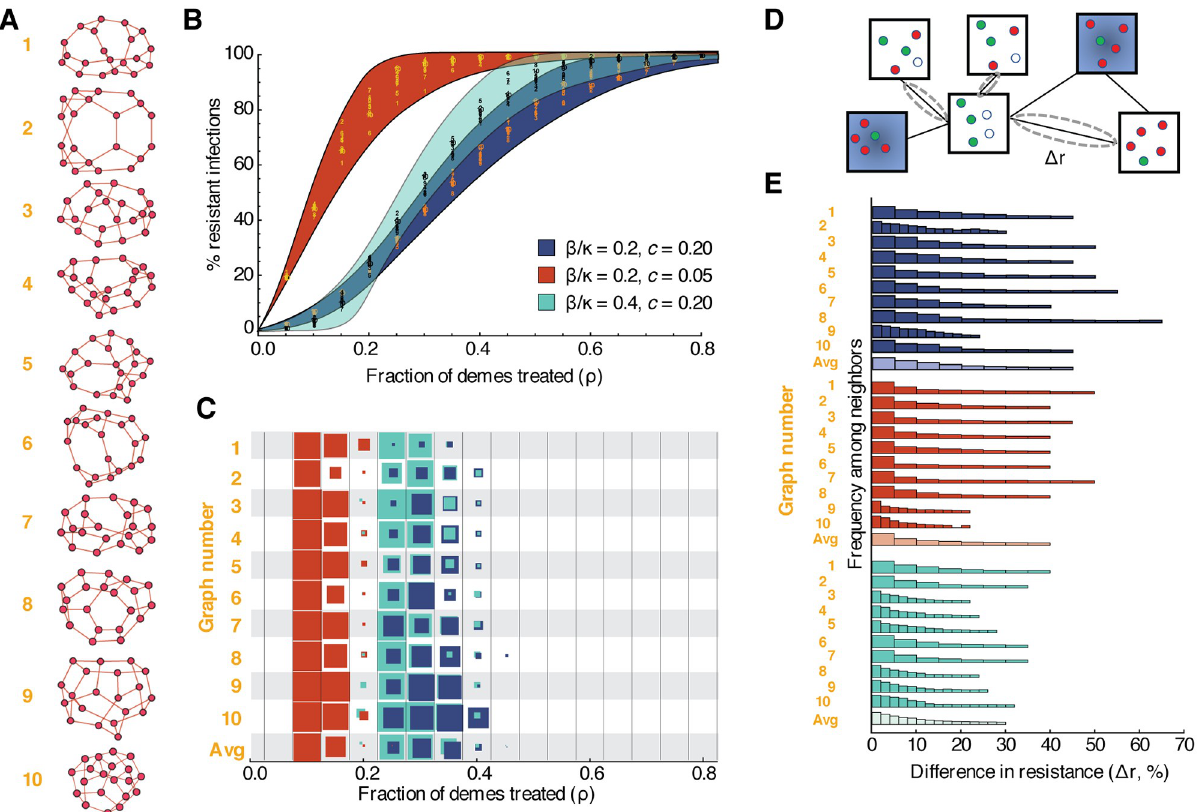
Fig 4. Dynamics of drug-resistant infections in populations consisting of networks of inter-connected demes. A) Randomly generated population structures on which infection was simulated. Each node represents a deme (a well-mixed sub-population of individuals), and each edge indicates that infection can spread in either direction between those two demes. Ten example populations were selected out of 1000 total simulated, each with twenty demes randomly connected to three neighbors each, to represent a broad range of outcomes. B) Fraction of infections that are resistant in the entire population ( y -axis) versus fraction of demes treated, ρ ( x -axis). Each color represents a different parameter set (blue background—baseline, red background—lower cost of resistance, teal background—more between-deme connectivity). Numbers show data points for the ten example populations. The colored envelope is created by shading between sigmoidal curves that encompass all the data. C) For each population structure shown ( y -axis) and each treatment level ( x -axis), the proportion of simulations that resulted in robust coexistence between drug-sensitive and drug-resistant strains is shown (by the colored area of the box). Robust coexistence was defined as at least 80% of demes supporting both strains at frequencies above 10%. D) Differences in resistance levels (% of all infections that are with the drug resistant-strain) are measured between all pairs of directly-connected untreated demes. E) Histograms showing the distribution of pairwise differences in resistance for a given population structure. Lighter shaded histograms combine results from all population graphs. All simulations used kinetic parameters κ = 0.25/day, g = 0.1/day, and � = 0.9, and pooled results from 100 simulations with different random allocation of treatment across demes. Pairwise differences were calculated with 30% treatment.